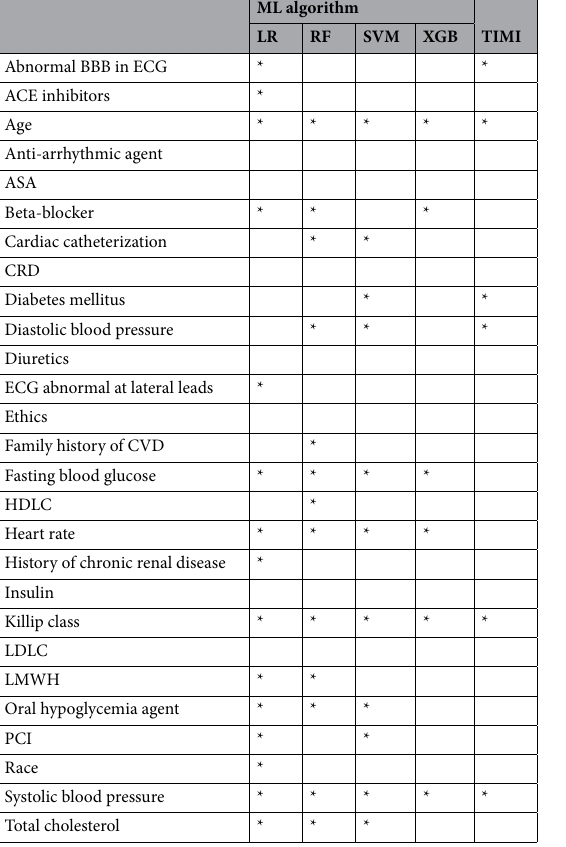
Table 4. Predictors of best ML models.